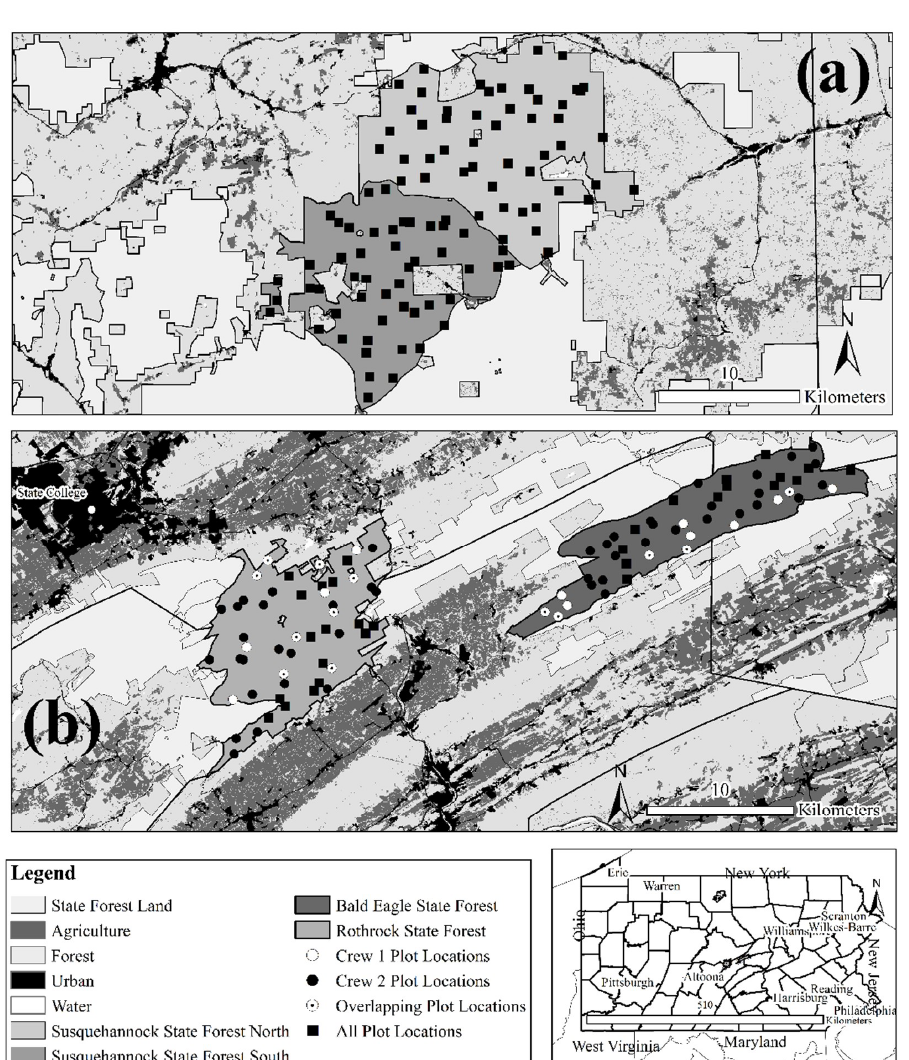
Figure 2. Map of the study area and Pennsylvania land cover (agriculture, forest, urban, and water). The study areas are highlighted by dark gray polygons (Susequhannock State Forest South, ( a ) bottom; Susquehannock State Forest North, ( a ) top; Rothrock State Forest, ( b ) left; Bald Eagle State Forest, ( b ) right), and are located on state forest land (light polygons). White circles represent plots sampled by crew 1 only (11), black circles represent plots sampled by crew 2 only (46), and white circles with black dots represent plots sampled independently by both crews (13). Black triangles represent additional plots sampled in the northern study area in 2015 (68).